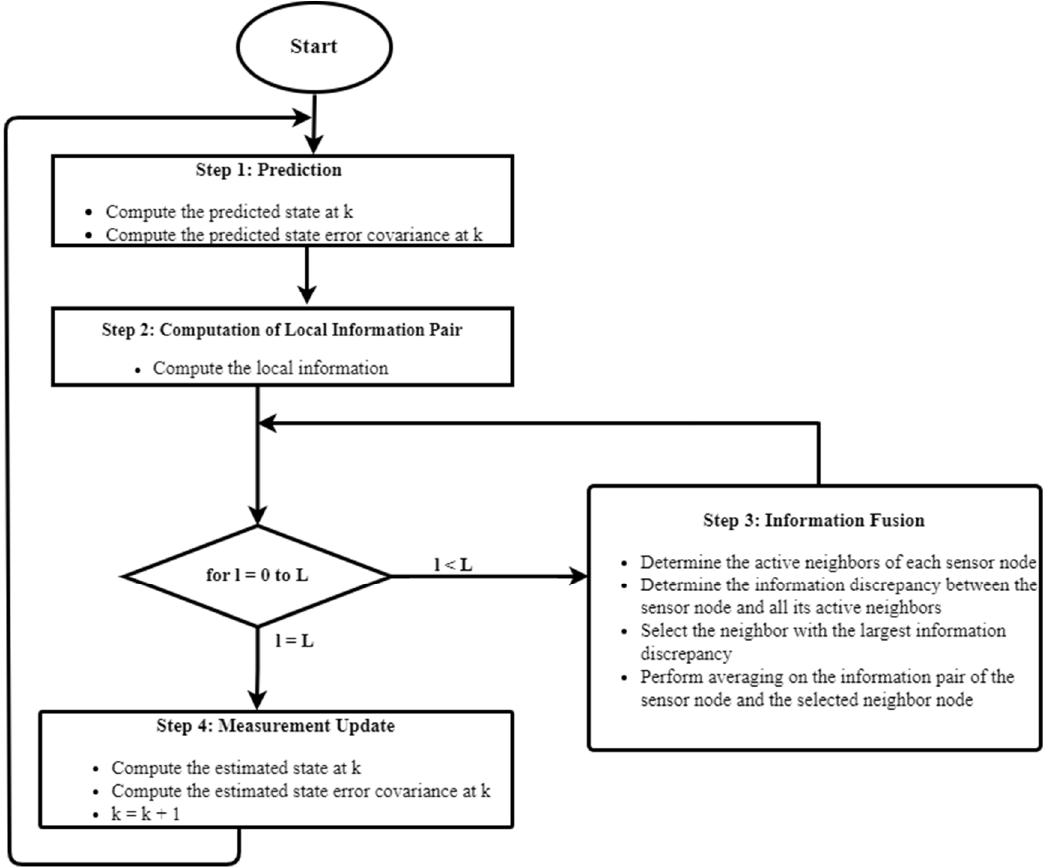
Figure 3. Flowchart of SGG-ICF algorithm.